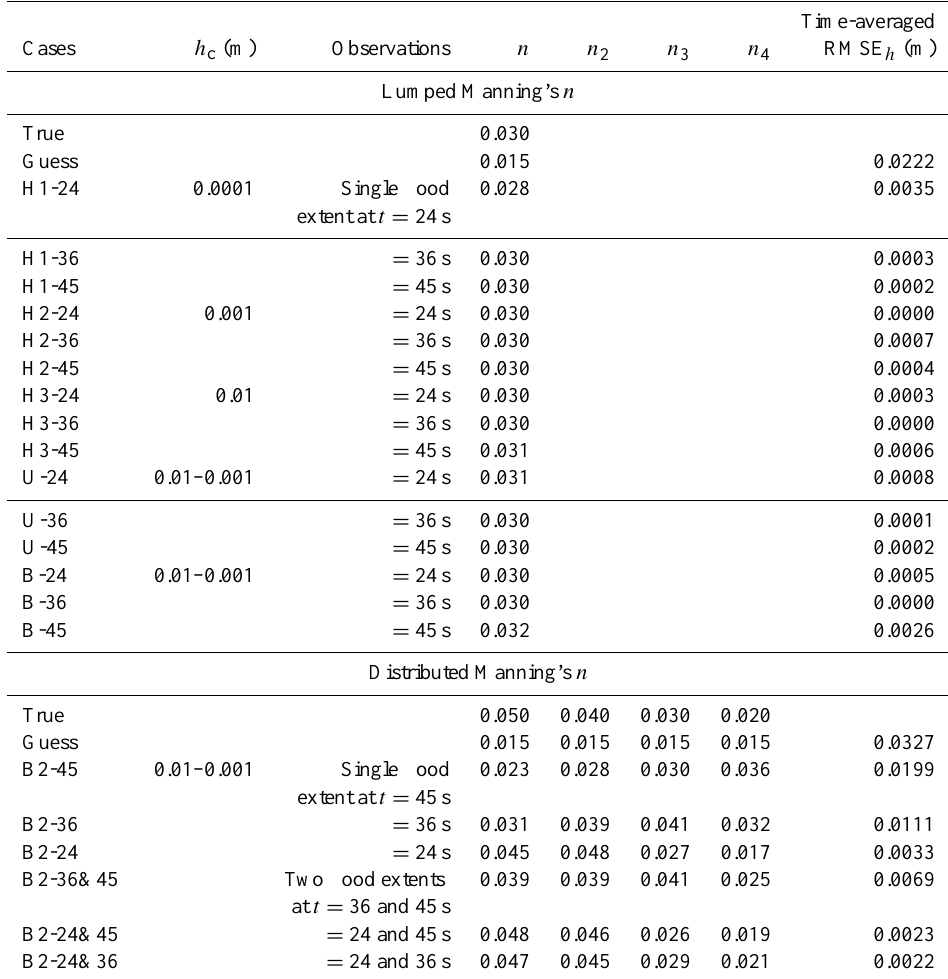
Table 4. The water depth threshold, h c , the assimilated observations, identified Manning’s n , and time-averaged RMS errors of water depth (RMSE h ) in the test case of dyke-break flood routing over three